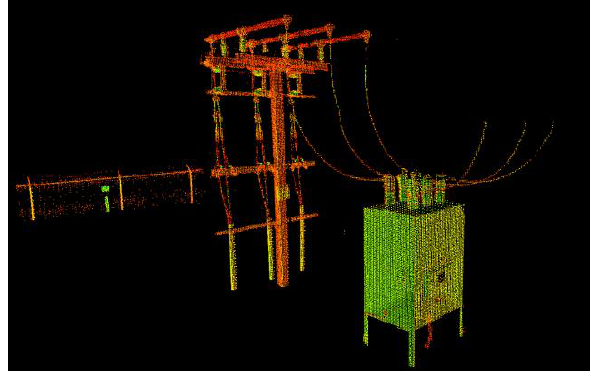
Figure 4. The subset of dataset utilized in this